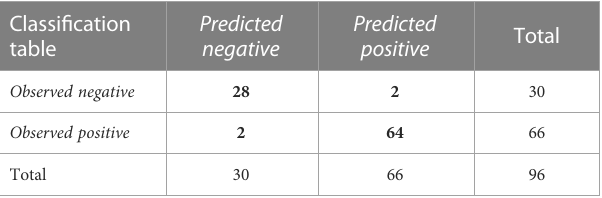
TABLE 1 Results of ROC analysis of the three miRNAs